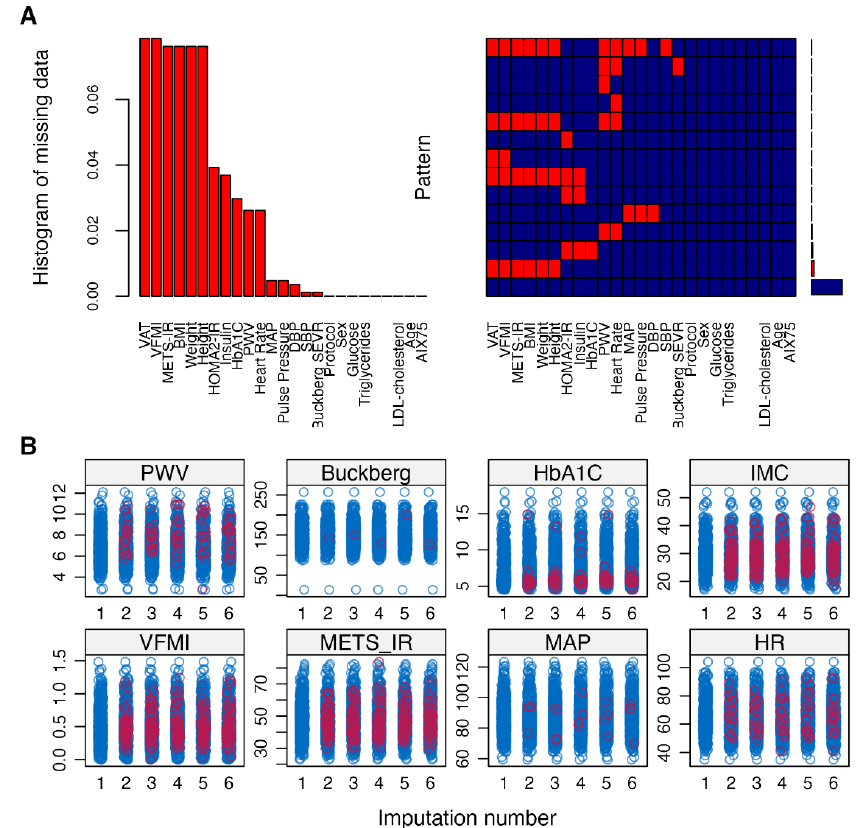
Figure A1. ( A ) Level and distribution of missingness for each variable, with visceral adipose tissue (VAT) having the most missing values. ( B ) Distribution of imputed values (red) after multiple imputations with the mice R package for selected imputed variables.